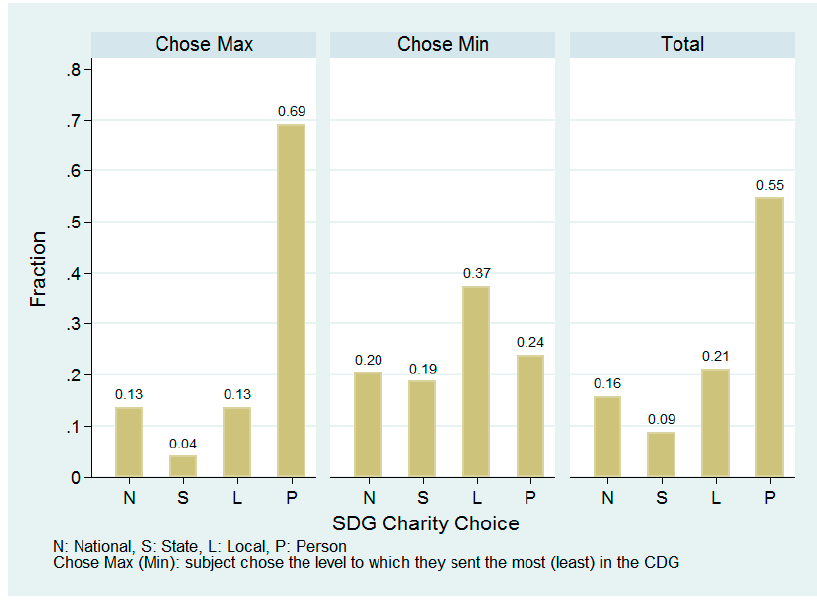
Figure 5. Proportion of subjects that chose each level in the SDG: those who chose their min charity, those who chose their max charity, and the full sample.